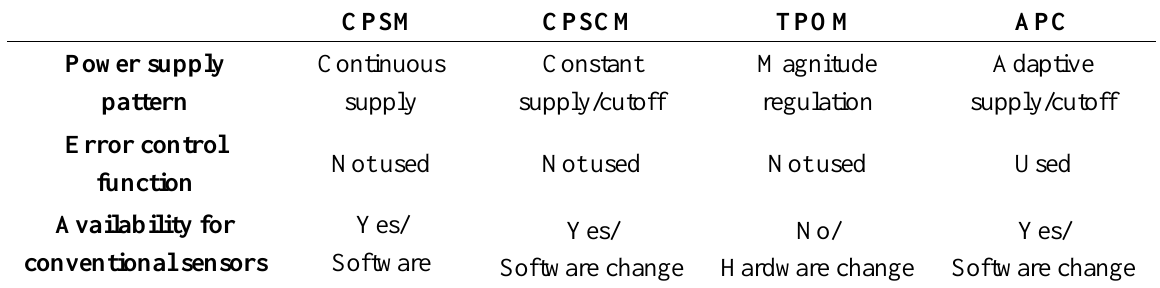
Table 1. Features of preheating control methods for gas